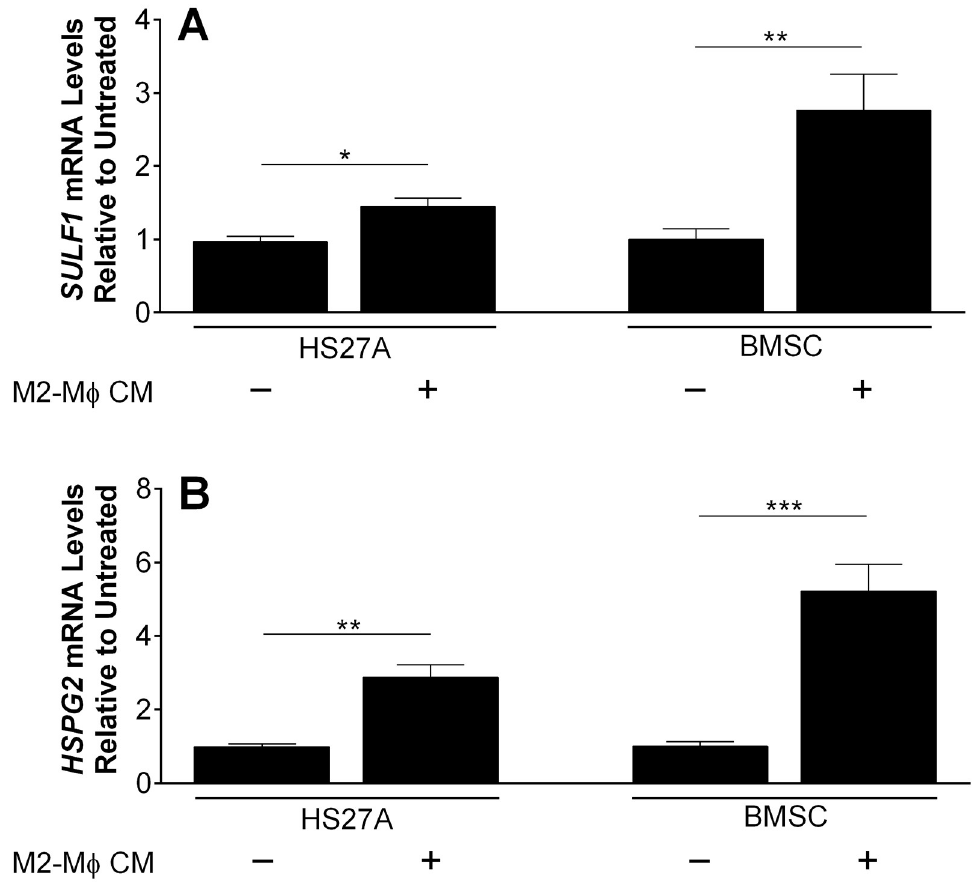
Fig 4. Expression of (A) SULF1 and (B) HSPG2 mRNA by human bone marrow fibroblasts stimulated by CM of M2-M ϕ s. HS27A and primary bone marrow stromal cells (BMSC) were treated with fresh CM from M2-M ϕ s for 48h